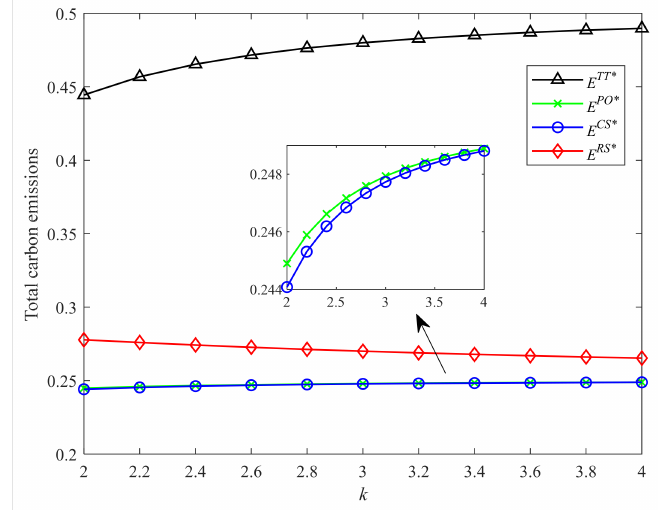
Figure 7. Comparison of total carbon emissions with different k